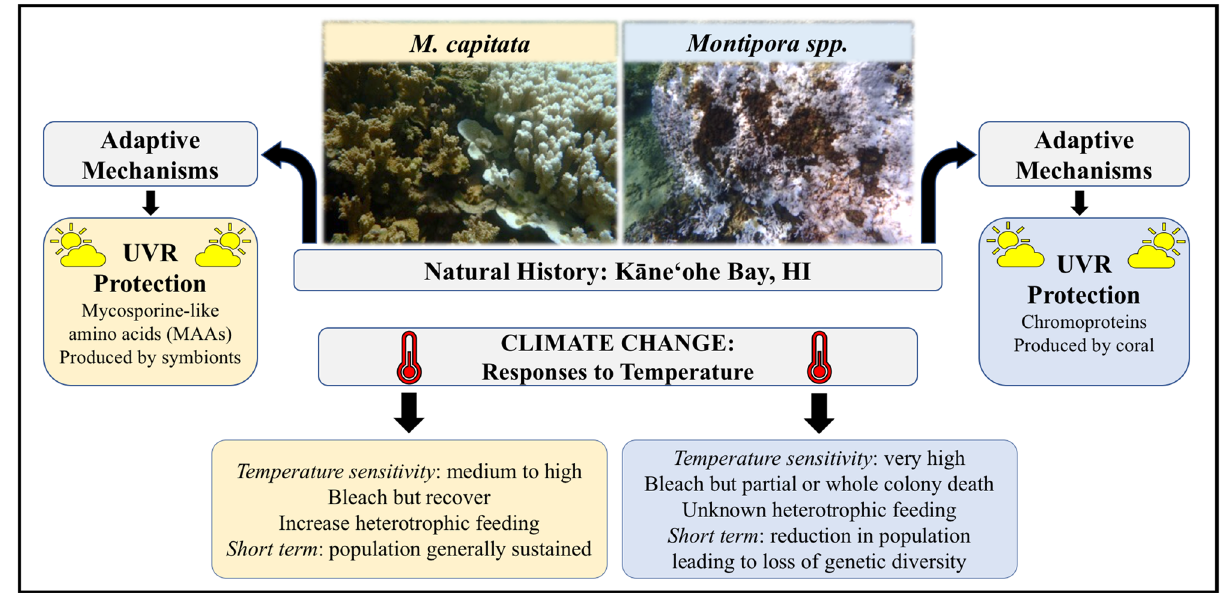
Figure 9. Physiological mechanism of UVR mitigation and response to thermal stress, M. capitata and Montipora spp . UVR protection for M. capitata is derived from MAAs that are produced by its symbionts whereas Montipora spp . produces its own chromoproteins that serve as UVR protectant. Montipora spp . is also more sensitive to elevated temperatures while M. capitata appears to be more robust, possibly by increasing heterotrophic feeding. This strategy seems unlikely for Montipora spp .